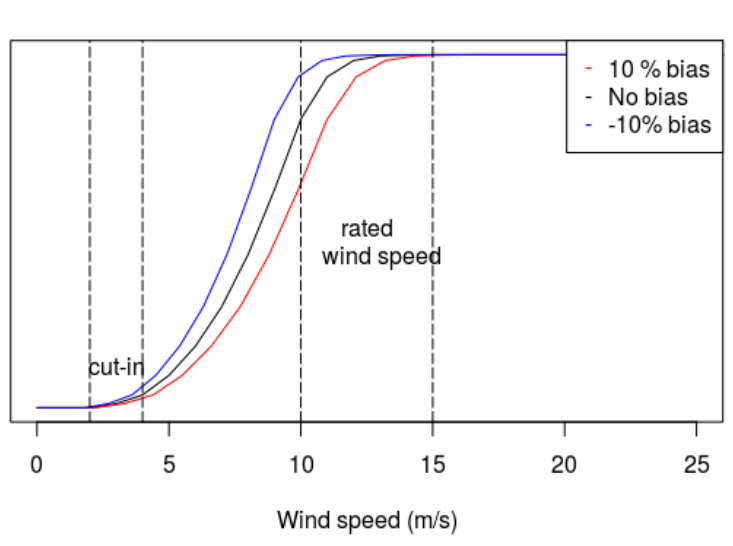
Figure 1. Power curves for different